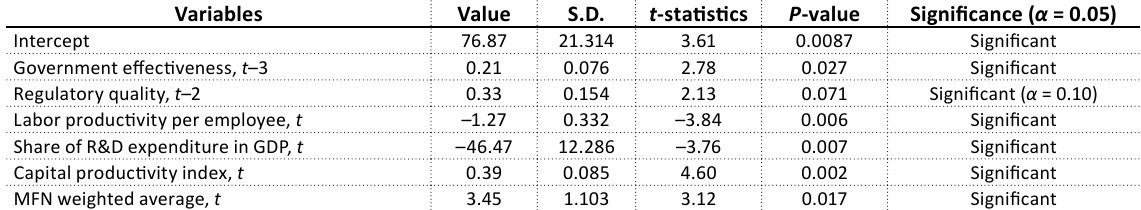
Table 3. Regression results